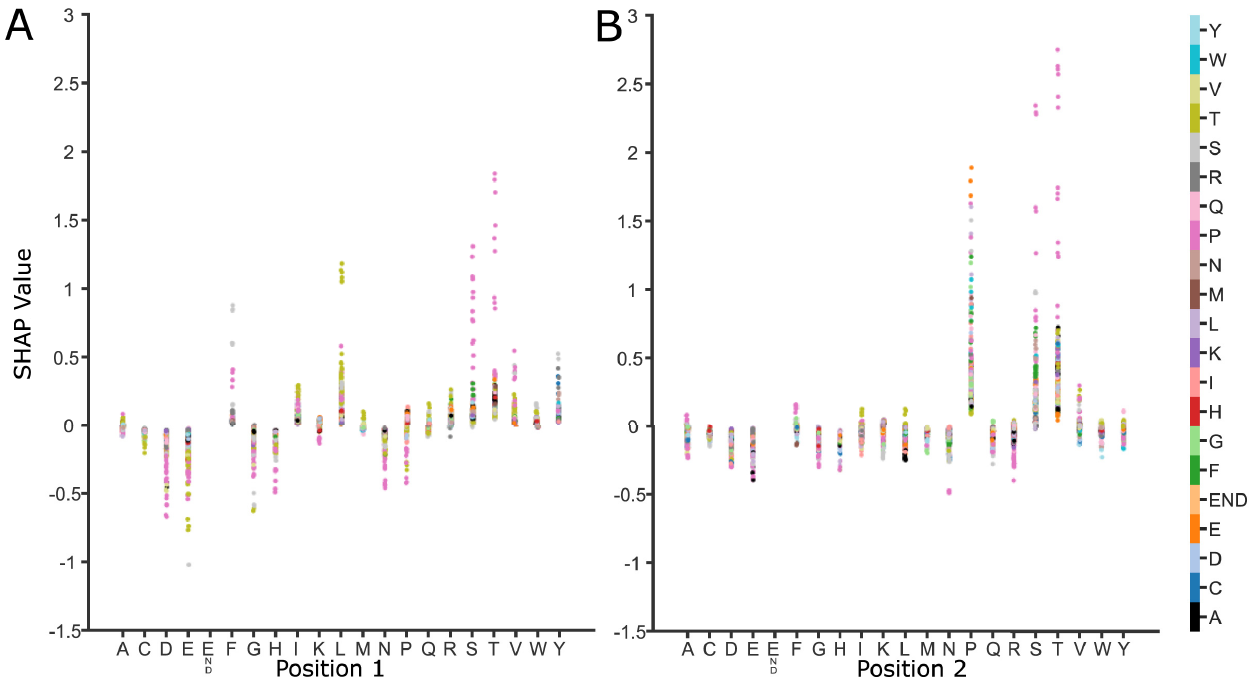
Fig 6. SHAP dependence plots for allele Mamu-A001 show how relationships between sequential amino acids contribute to binding. Each graph represents a pair of positions in the peptide, here (A) positions one and two and (B) positions two and three. The x-axis lists each possible amino acid for that position and the y-axis shows the SHAP value. Each point represents a peptide with the listed amino acid at that position on the x-axis and the amino acid in the subsequent position is shown by color. This shows how the range of SHAP values for a particular amino acid at a specific location is reflective of the dependence of other amino acid